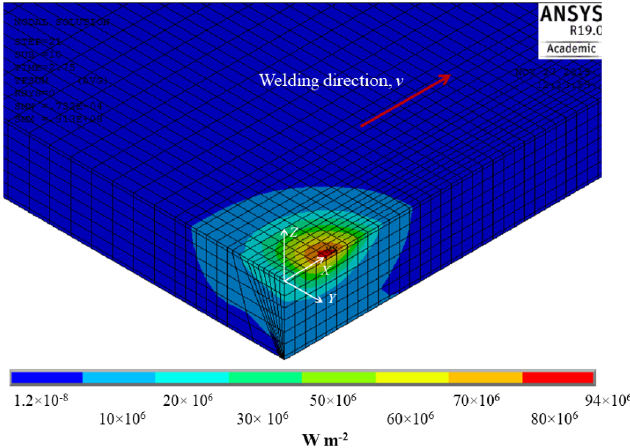
Figure 9. Contours of the heat flux distribution according to the double ellipse model (Figure 5). Units are in W m − 2 .